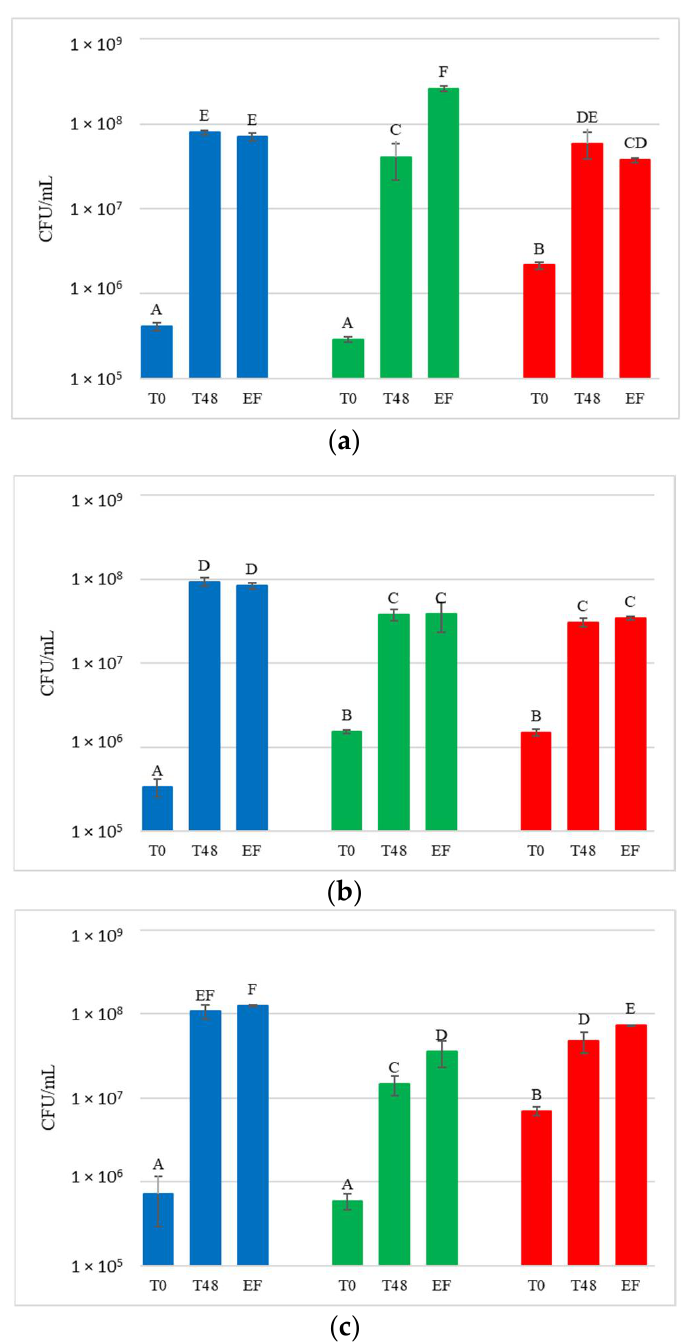
Figure 4. Total yeast concentrations measured during the fermentation in natural grape must. ( a ) JUICE, ( b ) CRYO and ( c ) JUICE+MARC. NT: untreated control (blue), LCC: low cell concentration (green), HCC: high cell concentration (red). Data are expressed as the average of three replicates ± standard deviations. For each figure, different letters indicate significant differences between values ( p = 0.05).